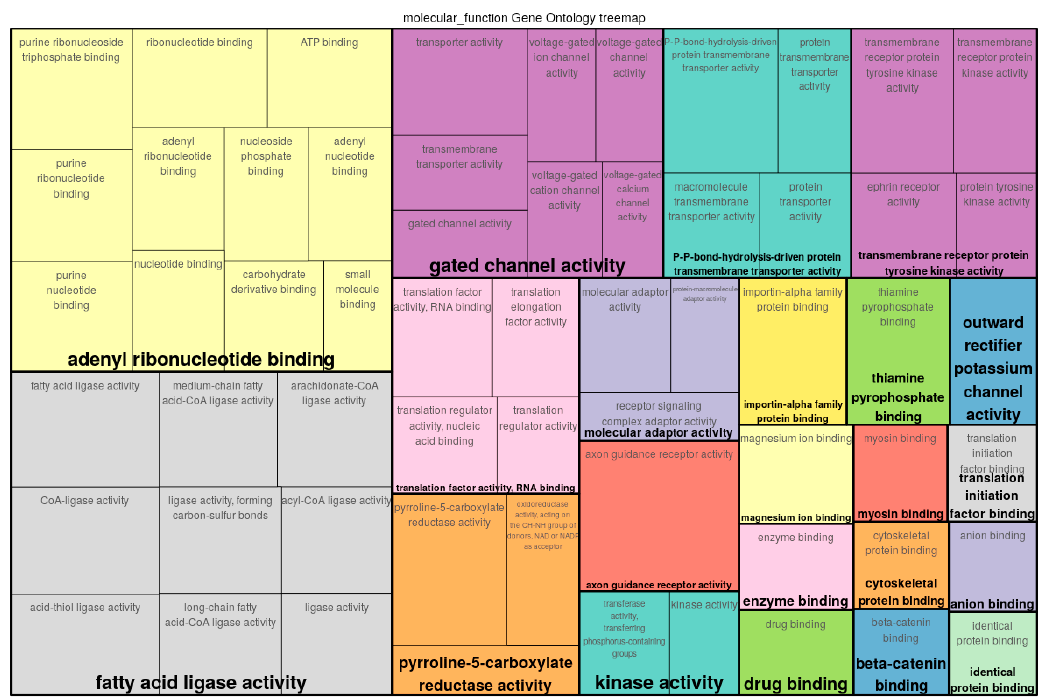
Figure 8. Gene Ontology (GO) treemap for genes associated with egg weight. The boxes are grouped together based on the upper-hierarchy GO term, which is written in bold